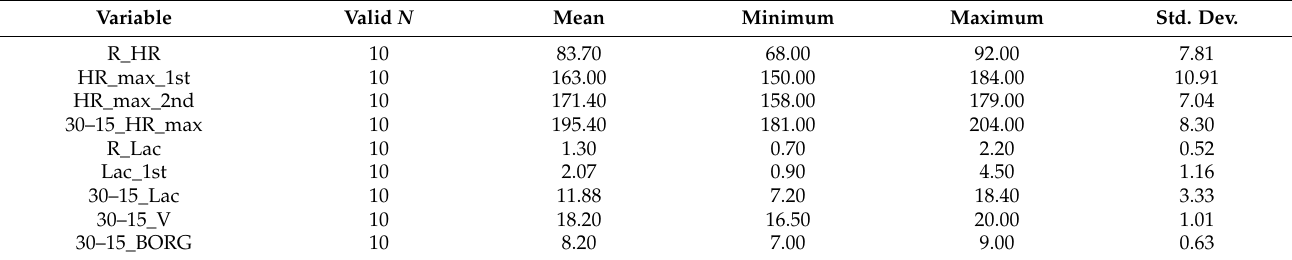
Table 2. Basic descriptive parameters of the selected variables.